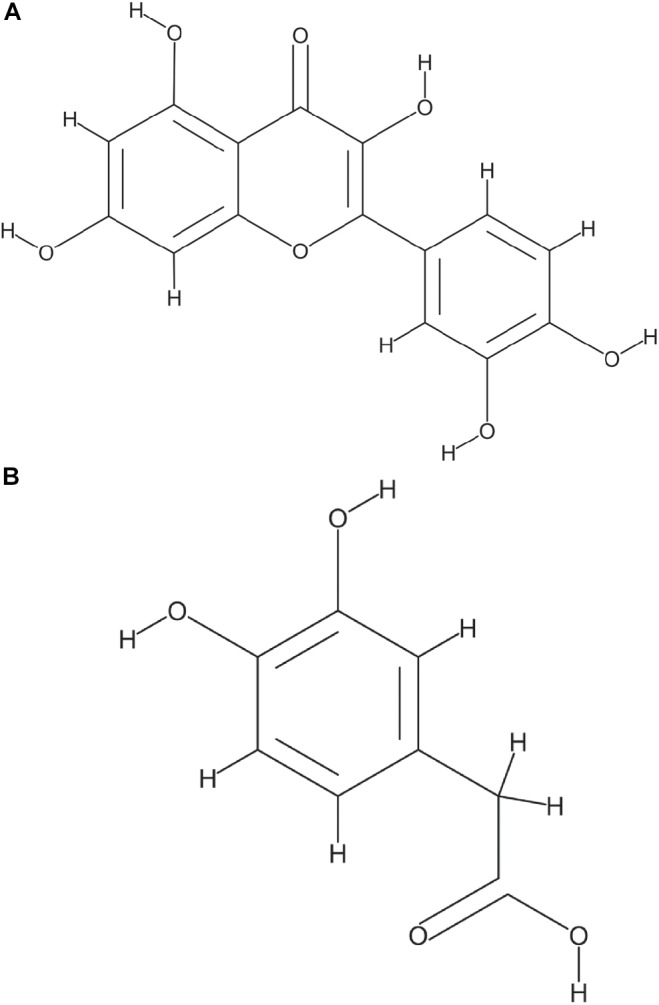
Structure of Quercetin (A) and 3,4-Dihydroxyphenylacetic acid (DOPAC), the main metabolite generated by E. ramulus from quercetin degradation (B) National Center for Biotechnology Information. PubChem Database, compound 5280343 and 547, respectively (https://pubchem.ncbi.nlm.nih.gov/).